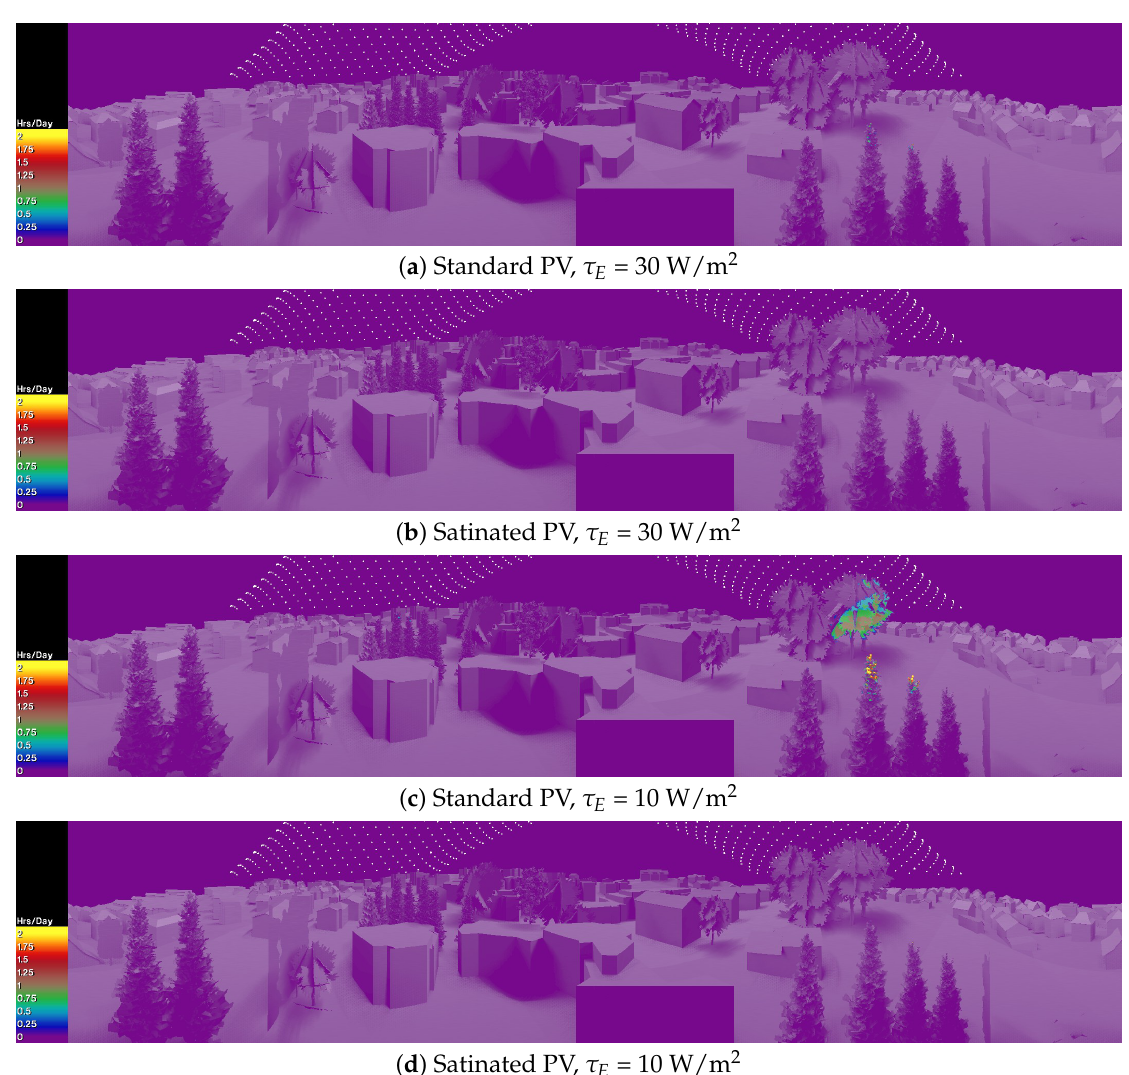
Figure 15. Panoramic views of maximum sustained glare duration in hours for any day of the year incurred by reflections from standard ( a , c ) and satinated ( b , d ) PV modules. Glare is identified according to irradiance thresholds τ E = 30 W/m 2 as recommended by Swissolar ( a , b ), and τ E = 10 W/m 2 as suggested by Sandia Labs ( c , d